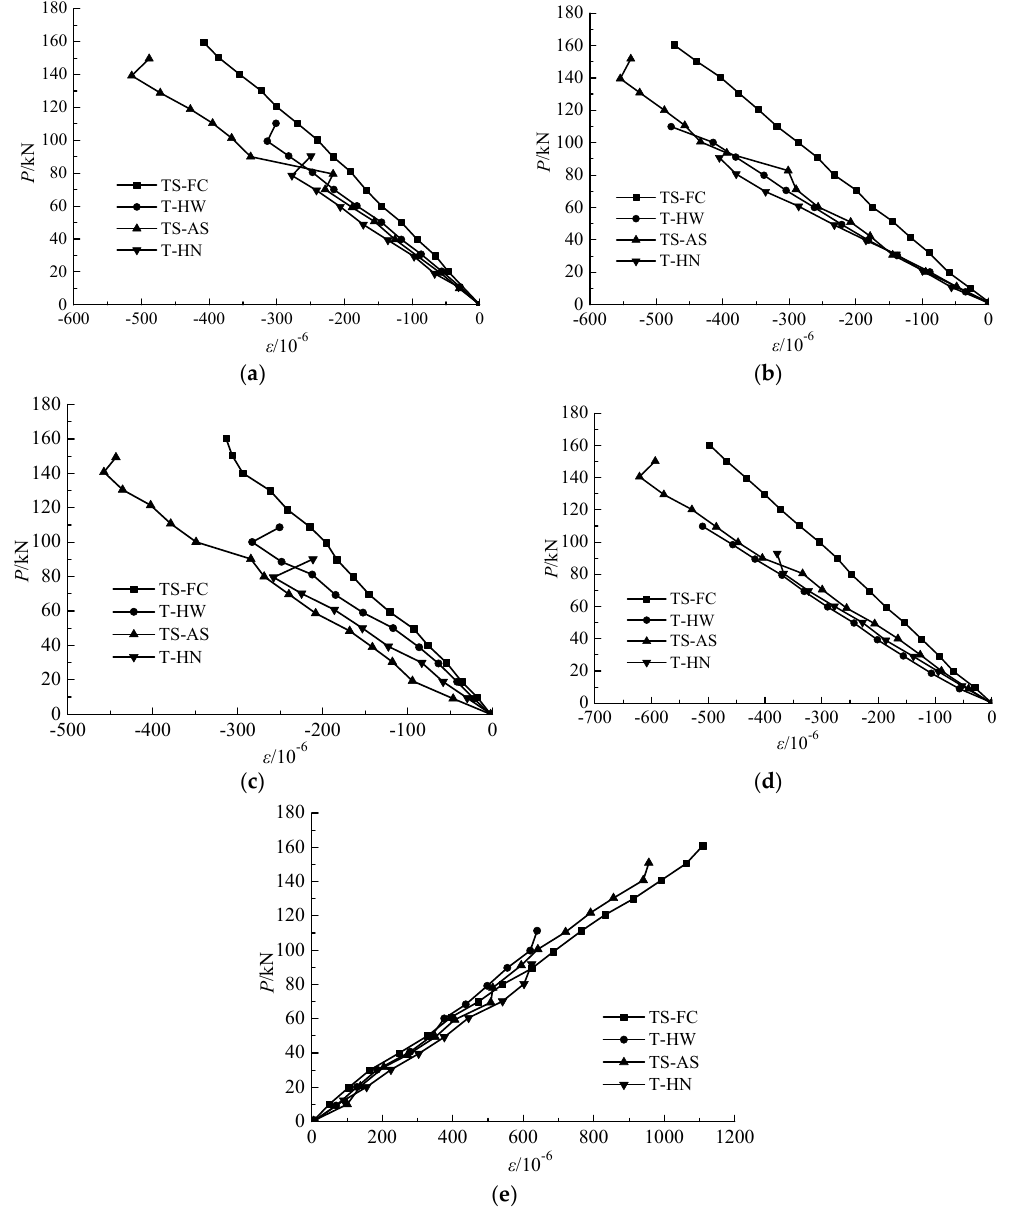
Figure 9. Total vertical loading–axial strain curves of chord members. ( a ) Top chord ‘hj’; ( b ) Top chord ‘fh’; ( c ) Top chord ‘gi’; ( d ) Top chord ‘eg’; ( e ) Bottom chord ‘no’.